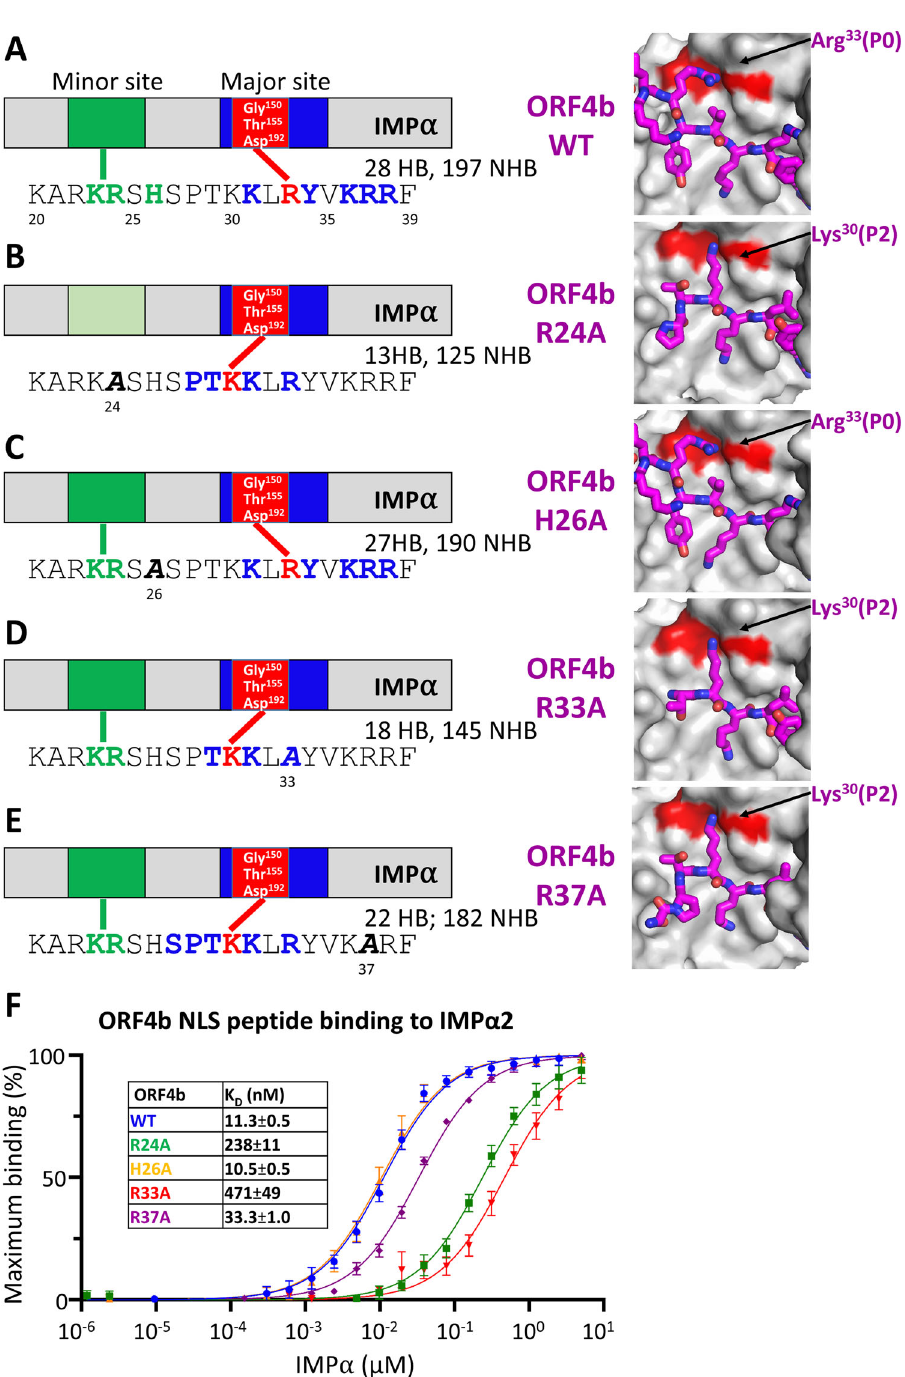
Fig. 3 Mutations to key residues at the MERS ORF4b binding interface change the binding mechanism to canonical Lys P2 site. A A wild-type peptide of MERS ORF4b was used as a control and crystallized with IMP α 2. As expected, the Arg33 bound at the Gly150, Thr155, and Asp192 pocket. A summary cartoon is presented, highlighting the minor and major site interactions and the structure presented in the right panel. A list of hydrogen-bonded interactions is presented in Supplementary Table 5. B An Arg24Ala mutation within the minor site, denoted in bold and italics with the numbering below the mutation is presented, showing a loss of minor site binding and change in binding mechanism at the major site. A list of hydrogen-bonded interactions is presented in Supplementary Table 6. C A His26Ala mutation, depicted as above, had little effect on the binding. A list of hydrogen-bonded interactions is presented in Supplementary Table 7. D An Arg33Ala mutation, depicted as above, caused a change in binding at the major site to the canonical P2 Lys binding. A list of hydrogen-bonded interactions is presented in Supplementary Table 8. E An Arg37Ala mutation, depicted as above, caused a change in binding at the major site to the canonical P2 Lys binding. A list of hydrogen-bonded interactions is presented in Supplementary Table 9. F Fluorescence polarization measuring the binding interaction of IMP α 2 with the crystallized mutants ( n = 3 biologically independent experiments). Error bars represent mean values ± SEM. R24A and R33A mutants had the greatest effect on binding. Source data are provided as a Source Data fi le. NLS nuclear localization signal, IMP α importin alpha, WT wild-type, HB number of hydrogen bonds, NHB number of non-hydrogen